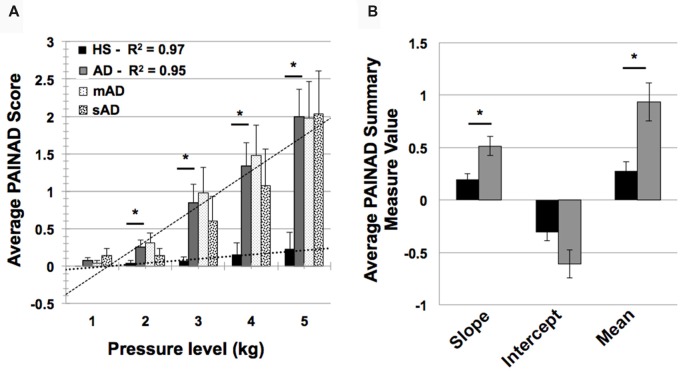
Group level behavioral pain responses (Pain Assessment in Advanced Dementia, PAINAD scale). (A) Average PAINAD scores for each pressure intensity (kilograms, kg) among HS and full AD groups; mild/moderate and severe (mAD and sAD) subgroups are also included. Associated linear regression lines are superimposed for HS and AD groups, allowing for visualization of slope of change and intercept across stimulus levels. (B) All PAINAD summary measures visualized as group averages, including slope of change, intercept and mean response. Asterisk indicates significant group difference at p ≤ 0.05 between HS and AD groups. Error bars represent standard error of the mean (SEM).